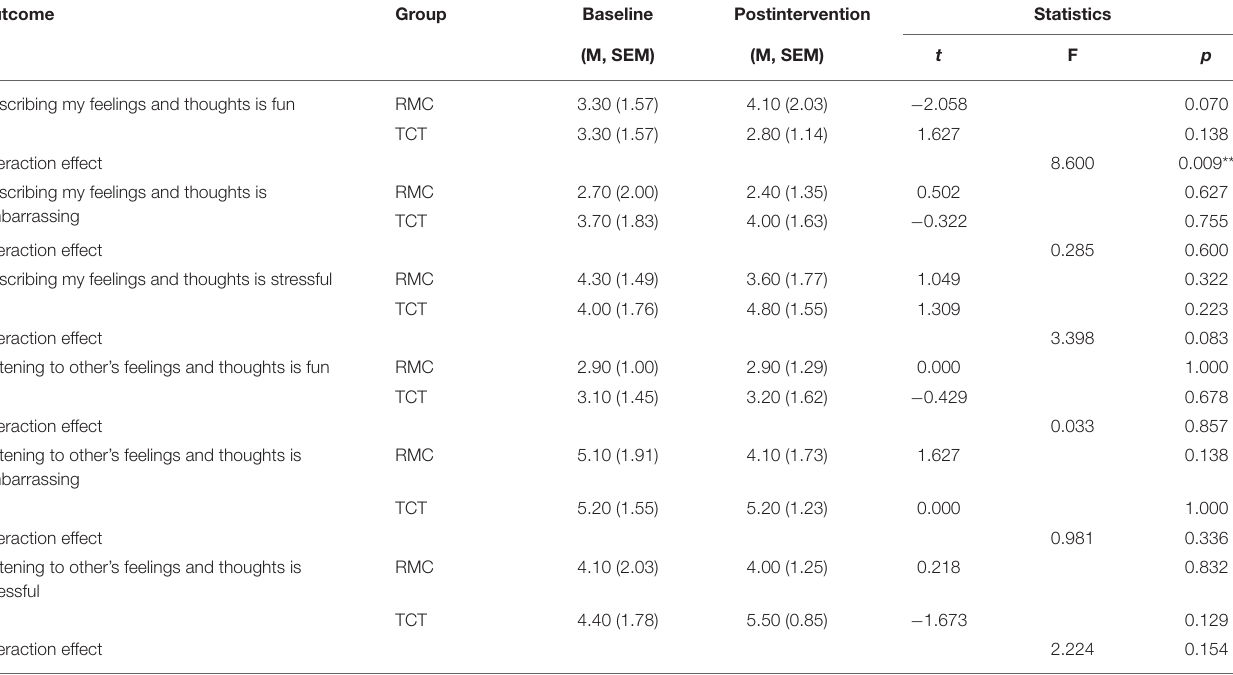
TABLE 3 | Means and standard devitation of the mean of the RMC group and TCT group for emotions related to communication at baseline and postintervention and interaction effects between the RMC and TCT groups on emotions related to communication. Outcome Group